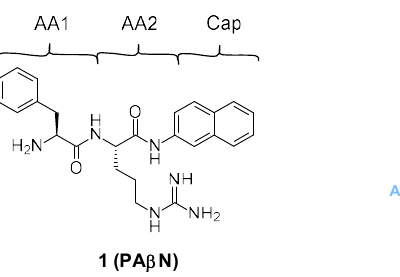
Figure 1. Structure of PA β N and summary of the different SARs.